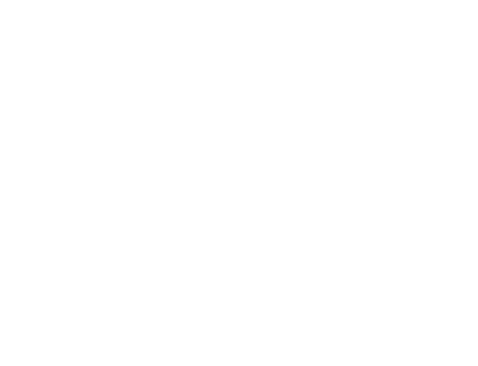
Table 2. Changes in clinical variables before and after CBT-I in PI ( n = 14).